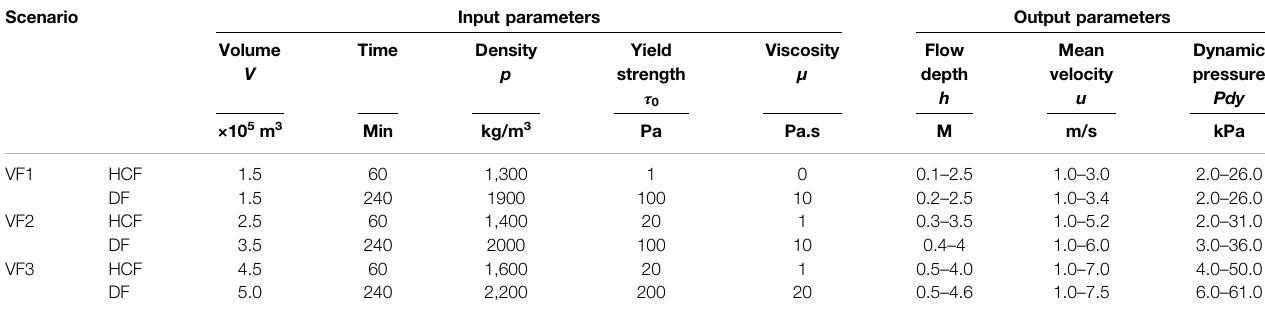
TABLE 9| Inputparameters used tosimulate HCFsand DFswith VolcFlownumericalcodeand outputparametersforthreedifferentscenarios.Theparametercisconstant for all simulations and equals to 0.001.